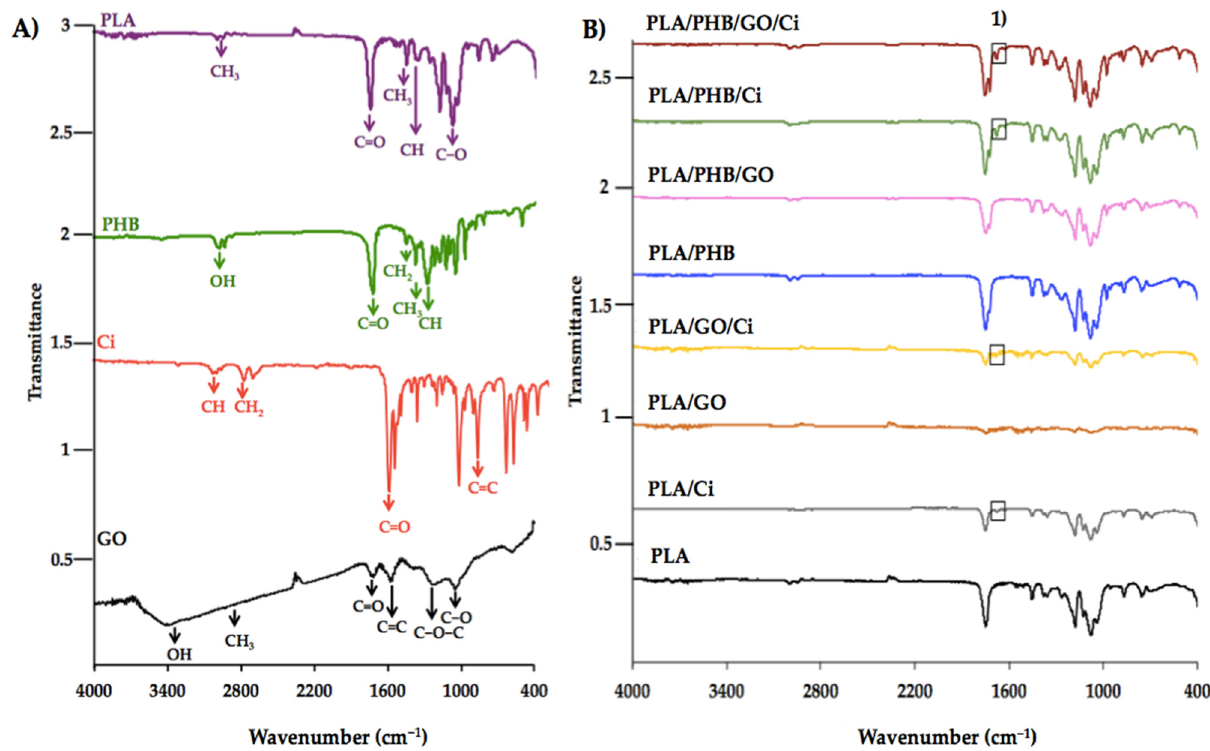
Figure 2. IR spectra of ( A ) PLA, PHB, Ci, GO and ( B ) blends and bionanocomposites. ( 1 ) Ci impregnation in films and blends.